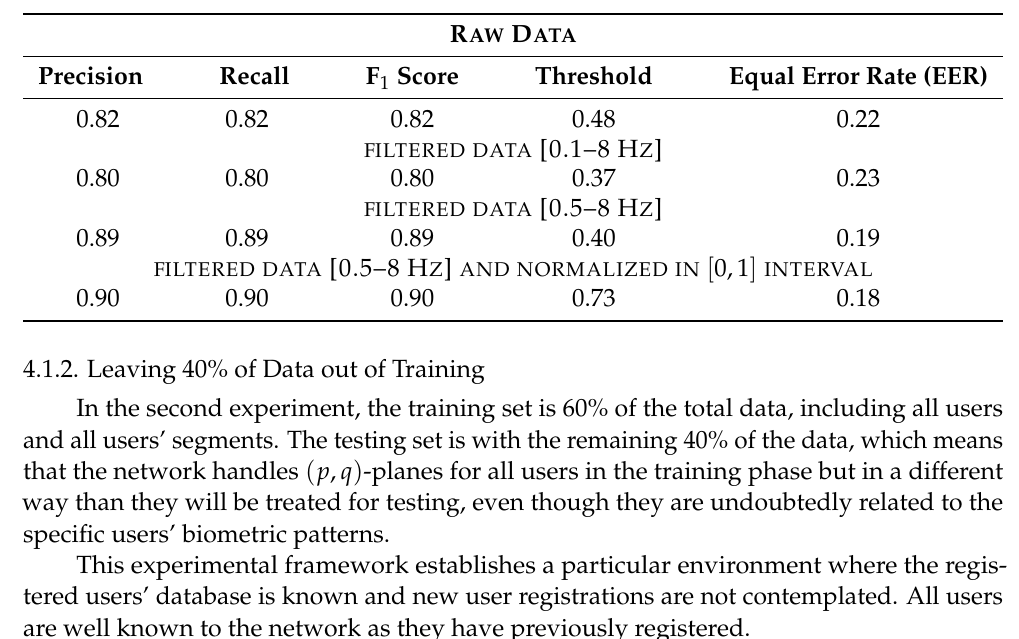
Table 2. Performance metrics for all the input PPG signal modalities used in the case of leaving 40% of users out of training. The thresholds refer to the optimal classification thresholds where EER is minimal for each modality (preprocessing) considered.